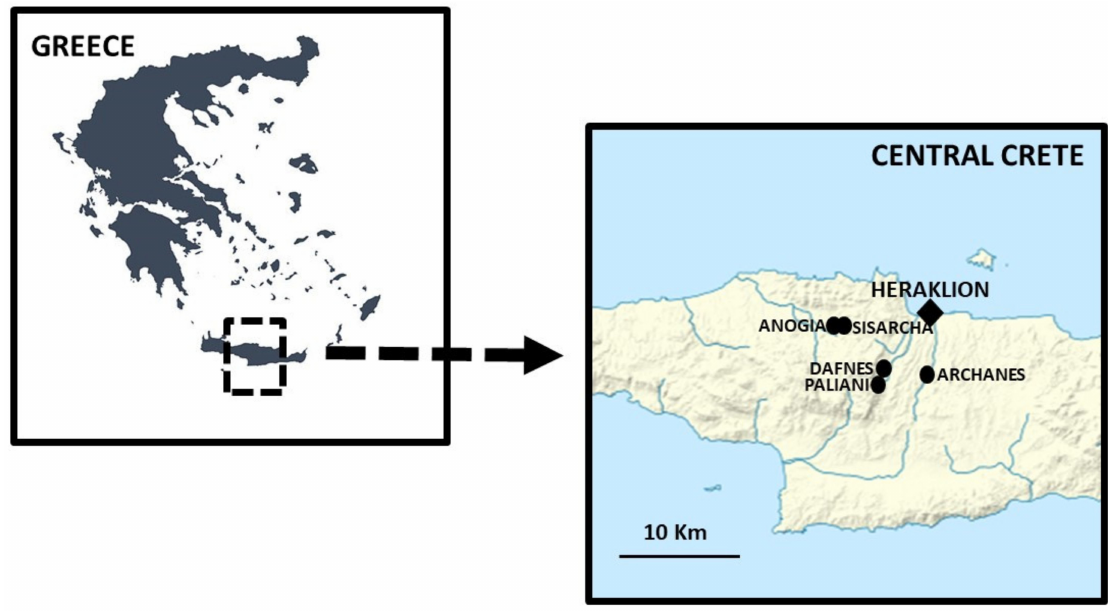
Figure 1. Location of the study area and visited villages. The rural landscape is characterized by typical olive orchards and vineyards at lower altitudes and by shrublands, pastures, and sheep herding at higher altitudes (Figures 2 and 3); the local economy is based on small-scale farming and tourism.